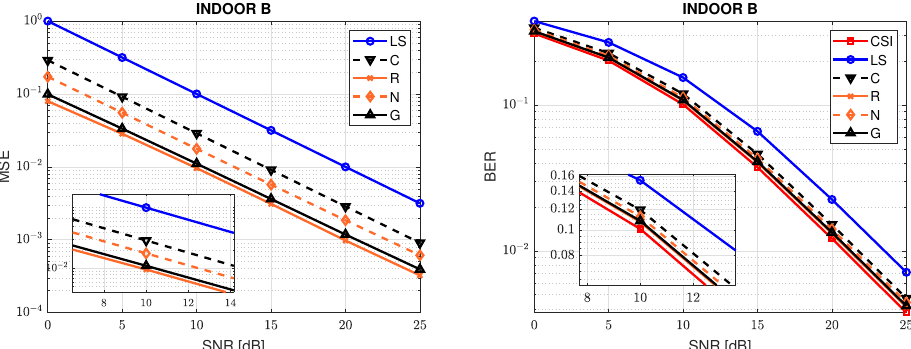
Figure 5. MSE and BER measures for Indoor B channel model.